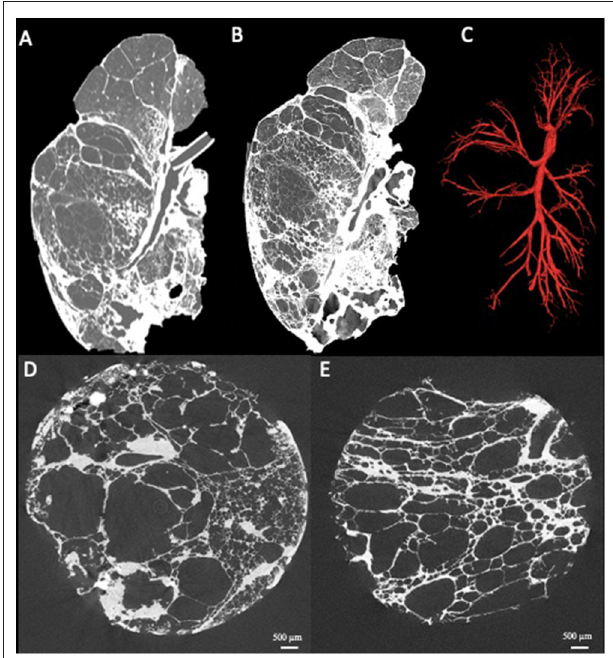
FIGURE 2 | Presentation of a case where clinical routine meets research. Patient with unilateral congenital emphysema that underwent pneumonectomy. The ex-vivo clinical CT scan shows severe emphysematous destruction (A) with some fibrosis in the lower lung lobe. The whole lung microCT shows greatly improved details providing near alveolar resolution (B) . Airway segmentation of the whole lung by microCT demonstrating the simplification of the airway tree characterized by a low number of visible airways and remarkable long airway segments without airway branching (C) . MicroCT imaging of extracted lung specimens showing the severe emphysematous destruction in this lung (D,E)